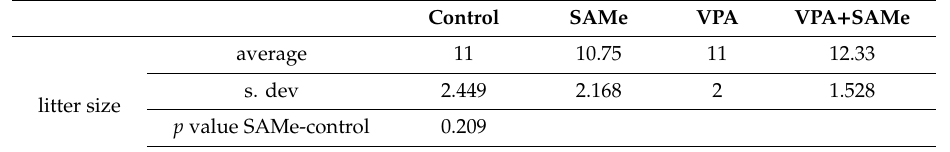
Table 1. Litter size analysis of the di ff erent treatment groups.